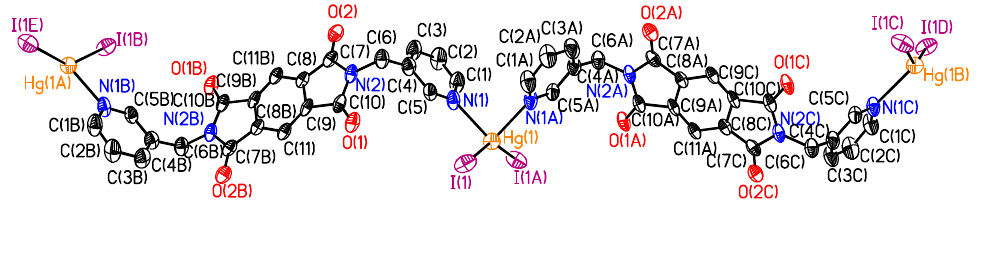
Figure 5. Molecular structure of 2 showing coordination geometry of Hg(II) ion. Hg(1)-N(1)#1 2.426(7), Hg(1)-N(1) 2.426(7), Hg(1)-I(1) 2.6402(7), Hg(1)-I(1)#1 2.6402(7) Å, N(1)#1-Hg(1)-N(1) 89.3(3), N(1)#1-Hg(1)-I(1) 108.16(15), N(1)-Hg(1)-I(1) 98.29(14), N(1)#1-Hg(1)-I(1)#1 98.29(14), N(1)-Hg(1)-I(1)#1 108.16(15), I(1)-Hg(1)-I(1)#1 142.64(3)°, symmetry code 1 = -x+3/2, y,